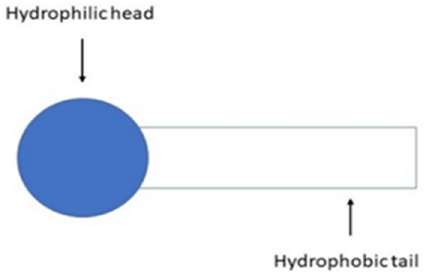
Fig. 9 Basic structure of demulsifier (Porter